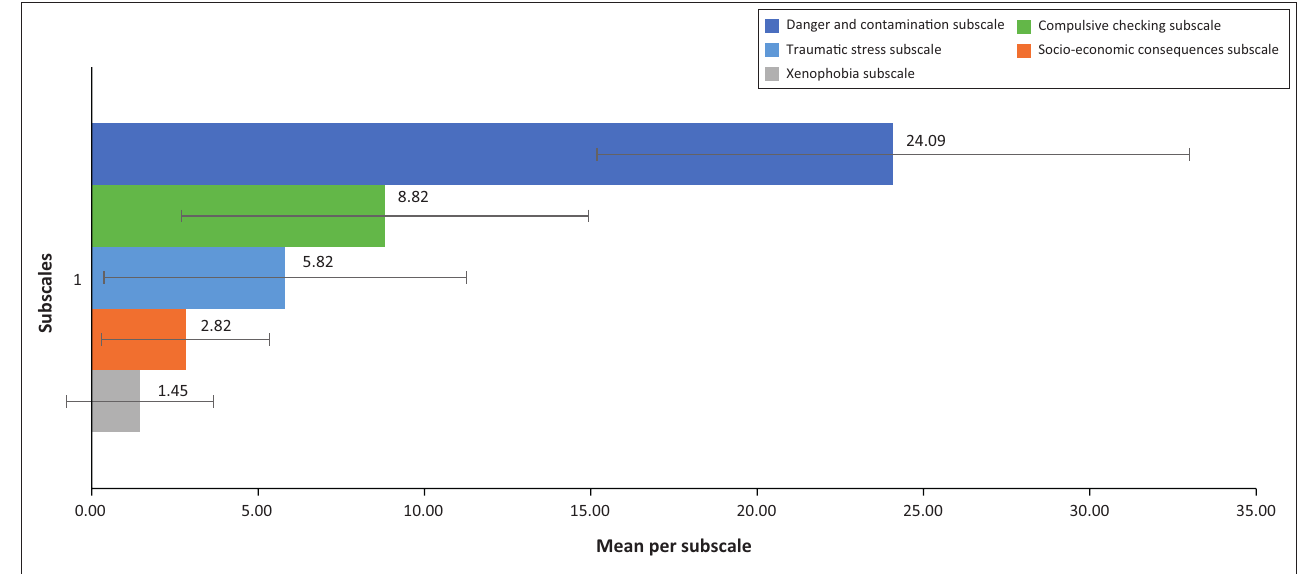
FIGURE 2: COVID-19 Stress Scale data with standard